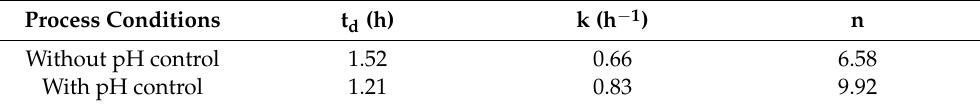
Table 2. Fermentation parameters evaluated during the exponential growth phase of fermentation with and without pH control: doubling time (t d ); constant growth rate (k); generation number (n). Process Conditions t d (h) k (h − 1 ) n Without pH control 1.52 0.66 6.58 With pH control 1.21 0.83